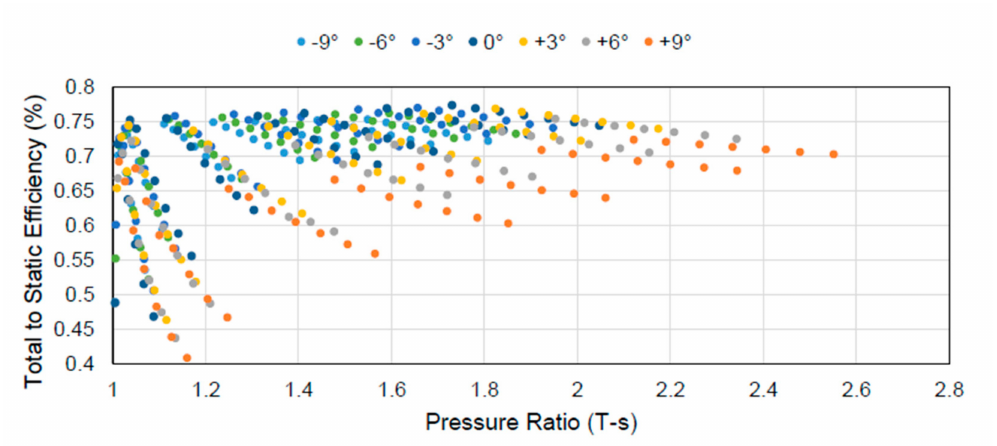
Figure 28. Total to static e ffi ciency vs. pressure ratio plots at constant shaft speeds at di ff erent rack positions for